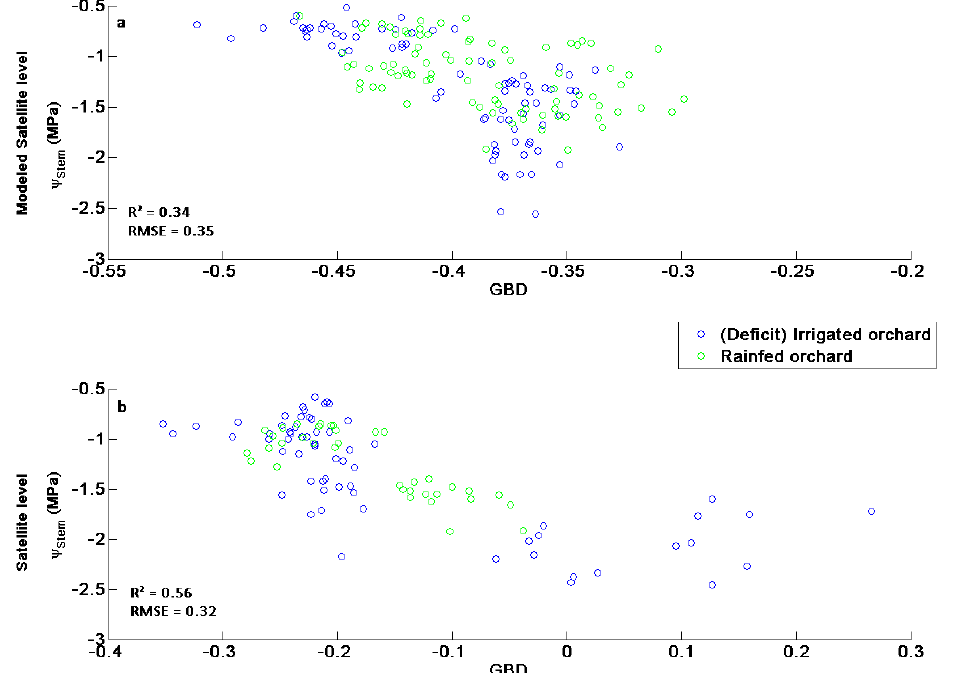
Figure 5. Scatter plot of Green Band Depth index (GBD; Equation (5)) with measured stem water potential ( Ψ ; MPa) for the modeled satellite level ( a ) and the satellite level stem ( b ). All points were labeled for